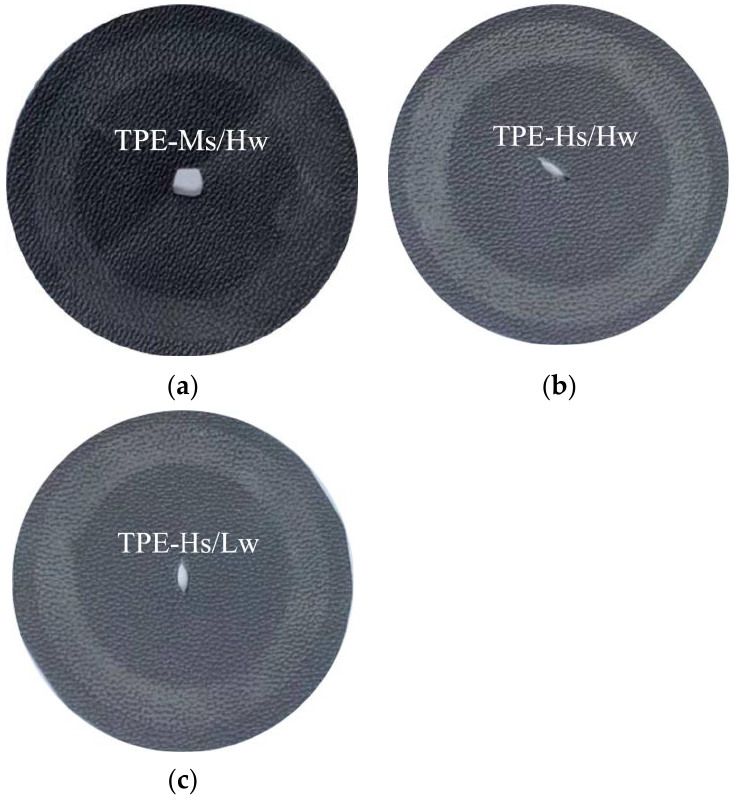
Figure 5. TPE samples prepared by SEBS with various styrene content after Taber abrasion. ( a ) TPE-Ms/Hw; ( b ) TPE-Hs/Hw; ( c ) TPE-Hs/Lw.